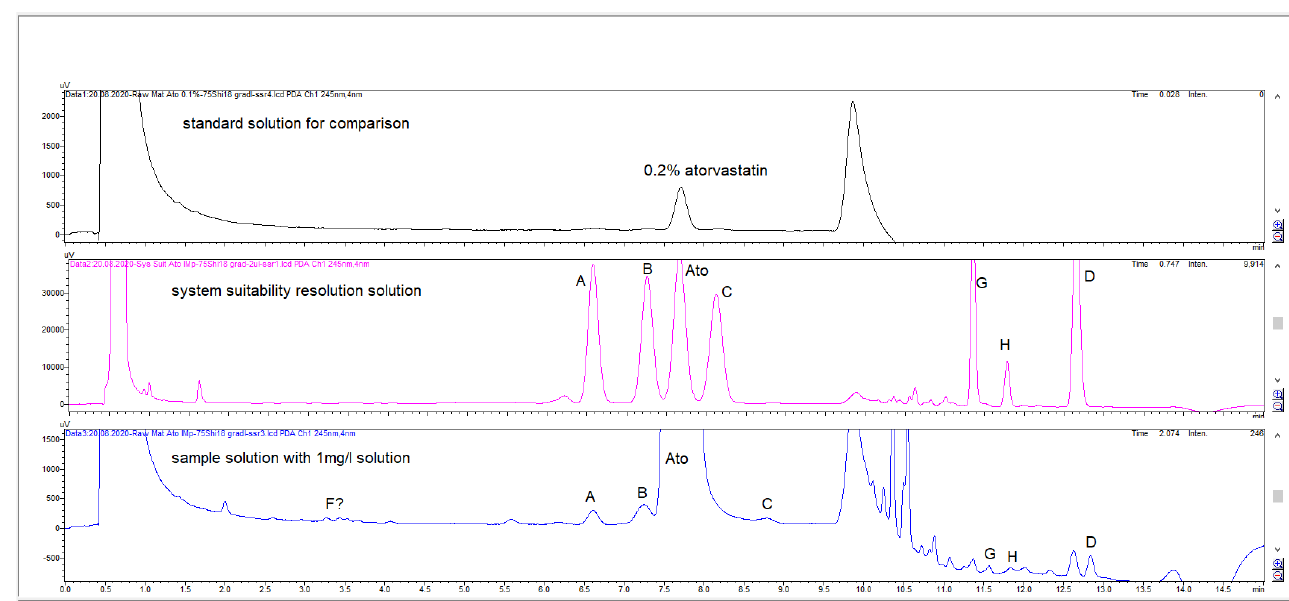
Figure 7. Summary overview of the selectivity and sensitivity of the method in 3 chromatograms illustrating: sample solution prepared from atorvastatin tablet ( bottom ), system suitability solution ( middle ), and diluted test solution corresponding to 0.2% atorvastatin ( top ). Table 2. Results from linearity testing of the method for analysis of atorvastatin and its impurities. Linearity Parameters Impurities Assay Atorvastatin concentration range (% of working conc. of test